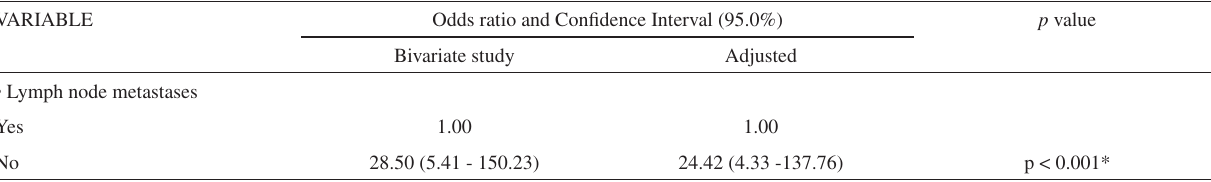
Table 3 - Logistic regression for cure (final medical condition)